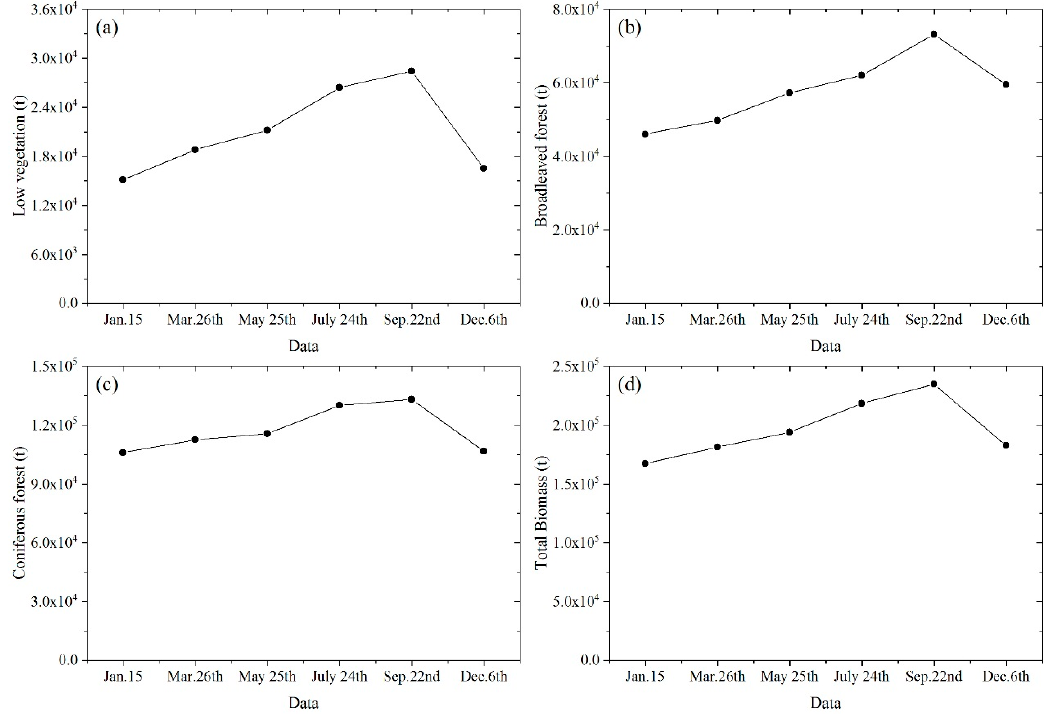
Figure 6. Type-specific biomass and the total vegetation biomass in the selected months of 2017: ( a ) low vegetation; ( b ) broadleaved forest; ( c ) coniferous forest; and ( d ) all vegetation. Overall, vegetation biomass increased over time and decreased after peaking in